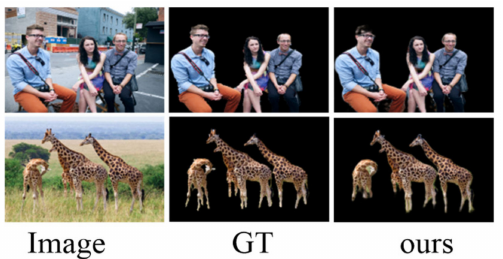
Figure 1. Example of background filtering based on salient object